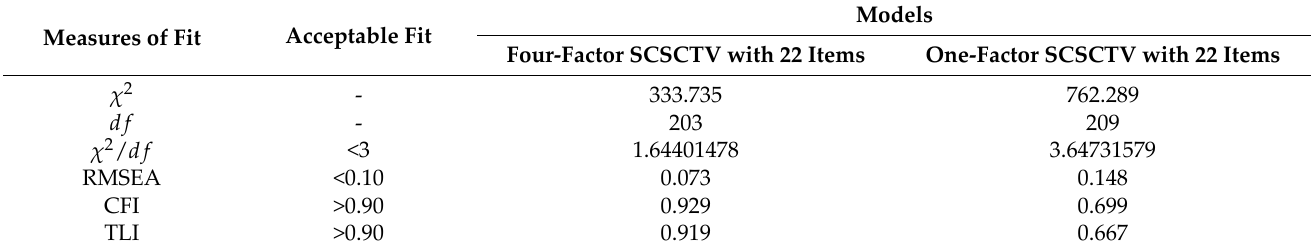
Table 6. Fit statistics for SCSCTV confirmatory factor analysis.